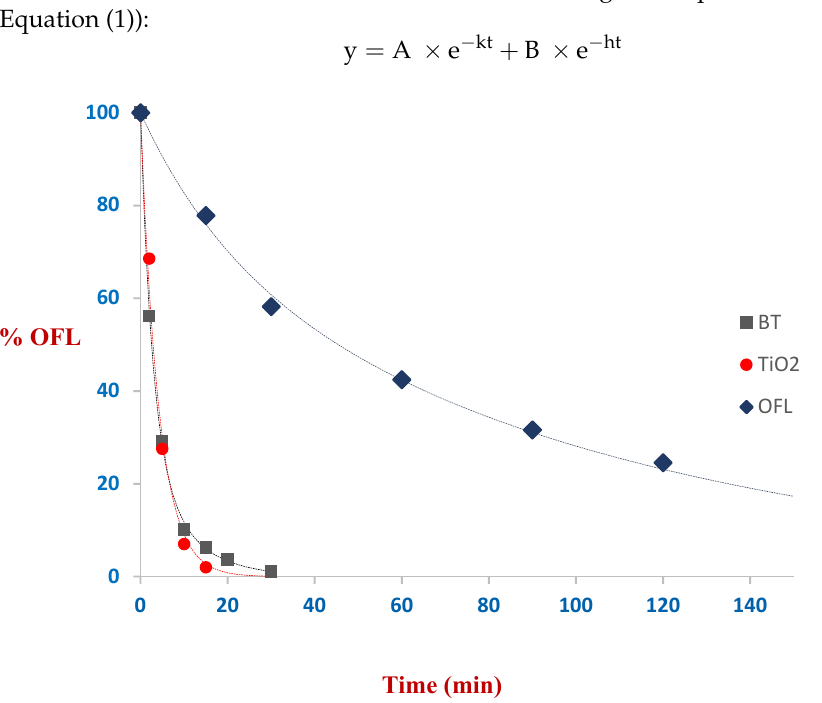
Figure 2. Kinetics of OFL decomposition: photolysis and BT photocatalysis referred with TiO 2 photocatalyst.